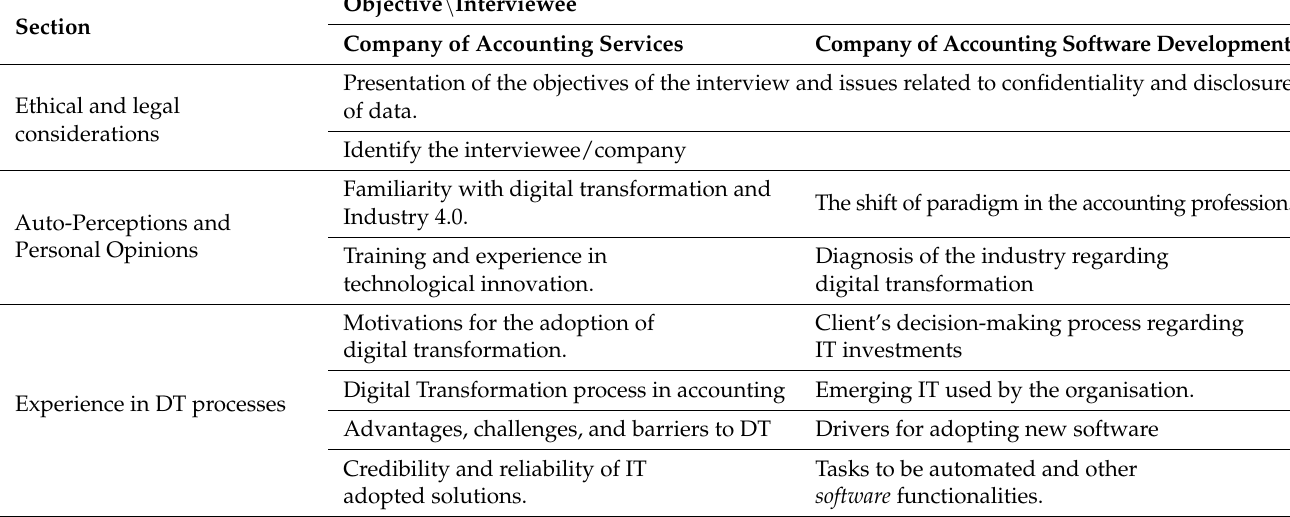
Table 5. Summary of interview